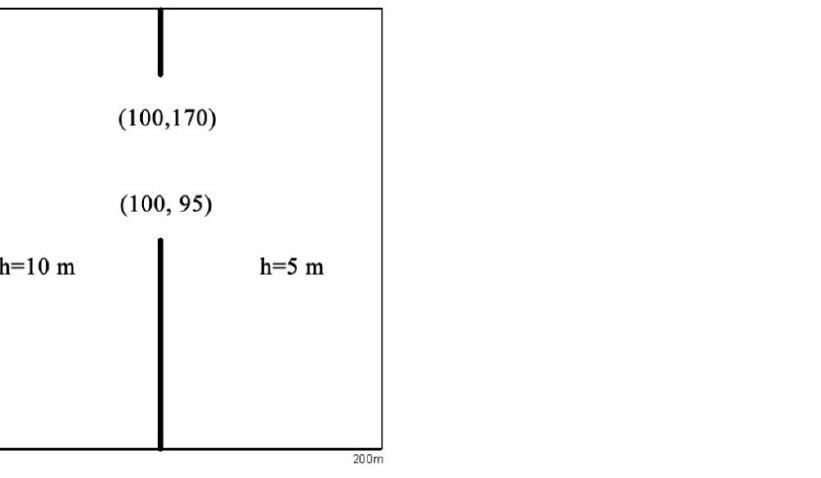
Figure 11. Layout of the two-dimensional dam break simulation in the benchmark study of Fennema and Chaudhry [42].